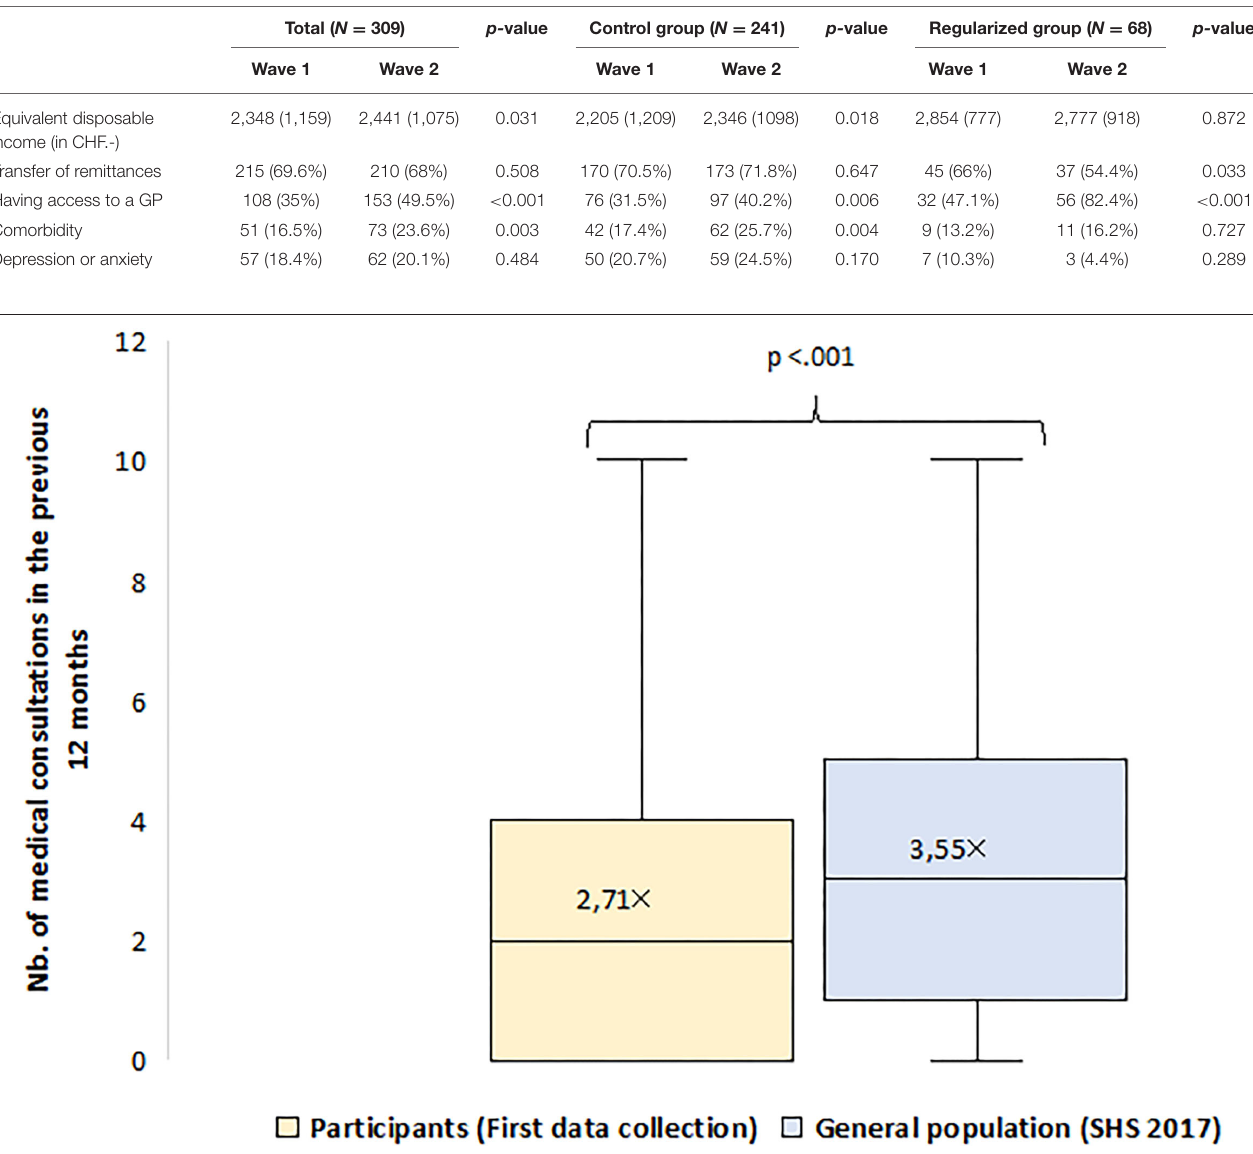
FIGURE 2 | Healthcare utilization of study participants (first data collection), as compared to the general population in